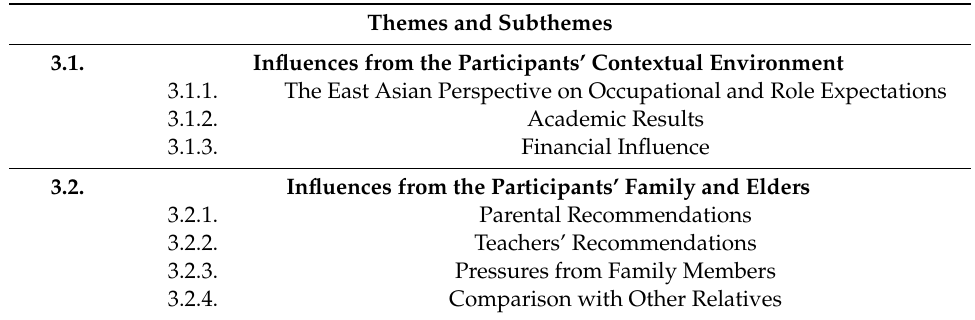
Table 1. A list of themes and subthemes for this